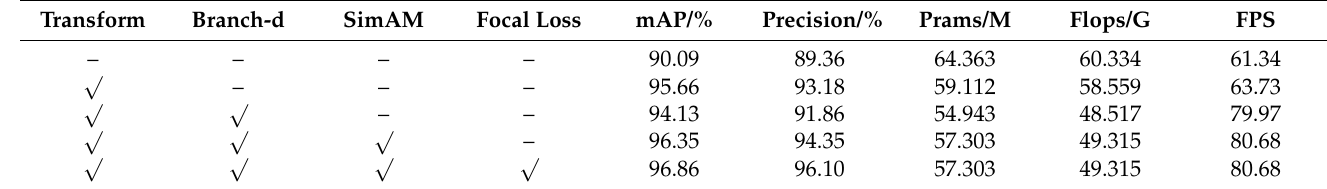
Table 5. Comparative analysis of ablation.